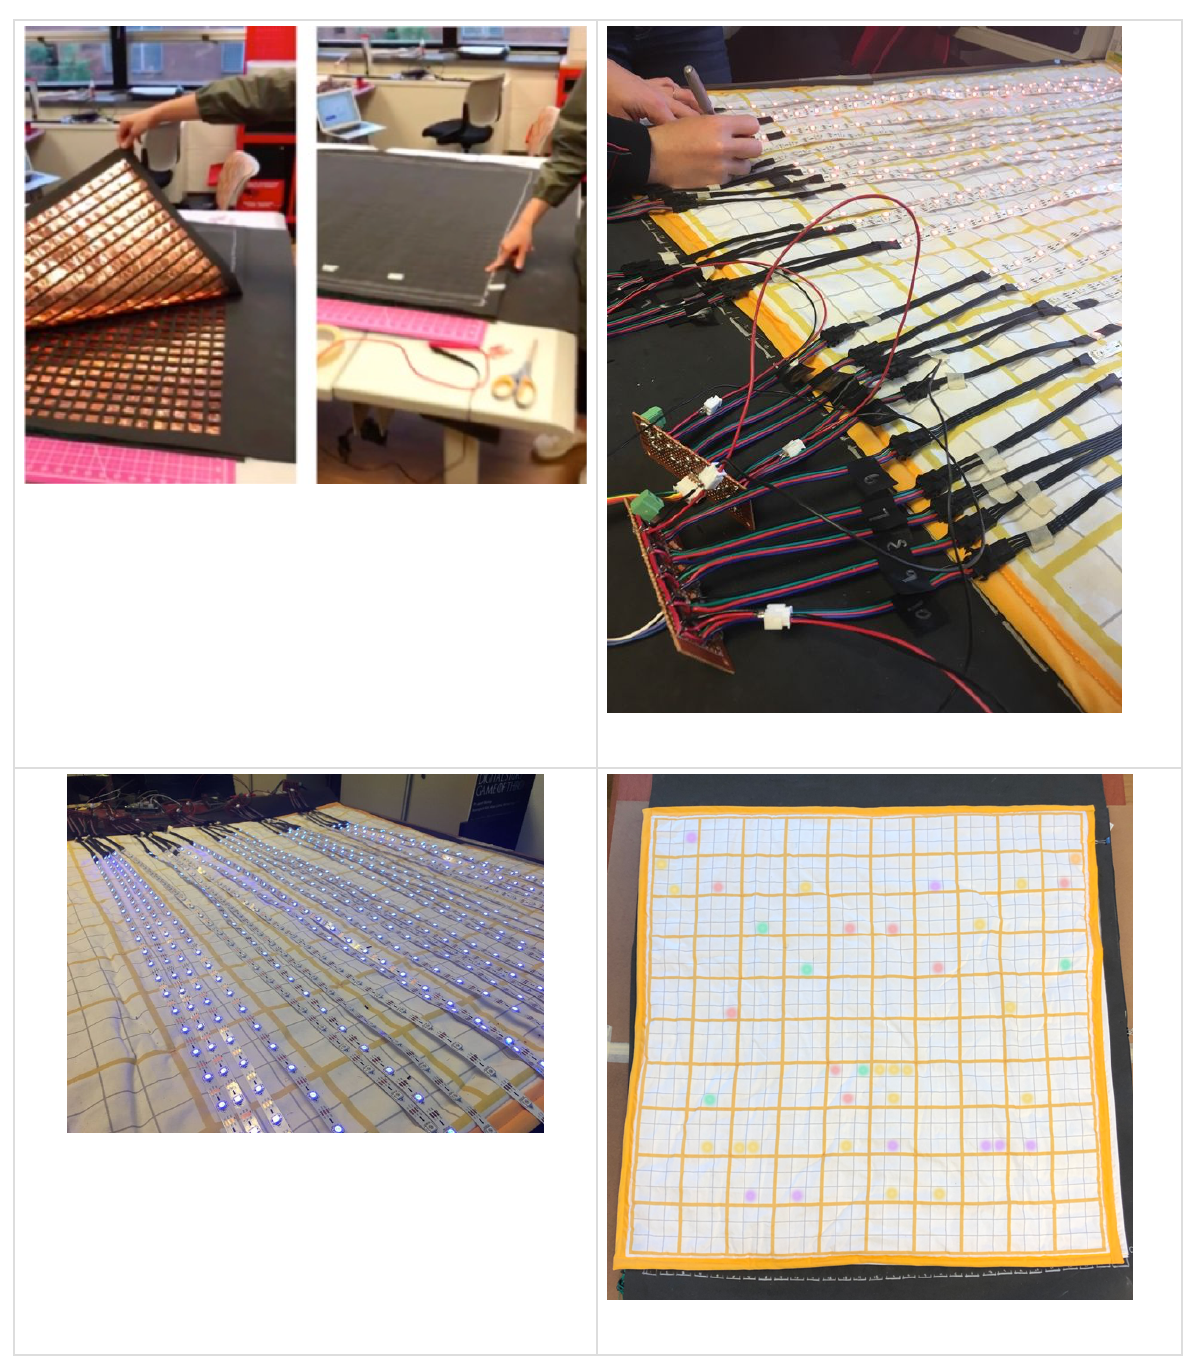
Figures 22–26 (left to right, top to bottom). The layers of the touch interface, built with copper tape and a foam spacer; the assembled touch interface; a view of the modular circuit boards for communicating with the LEDs; the LED system displayed on top of the quilted chart; a rendering of the completed Floor Chart. Photos by the